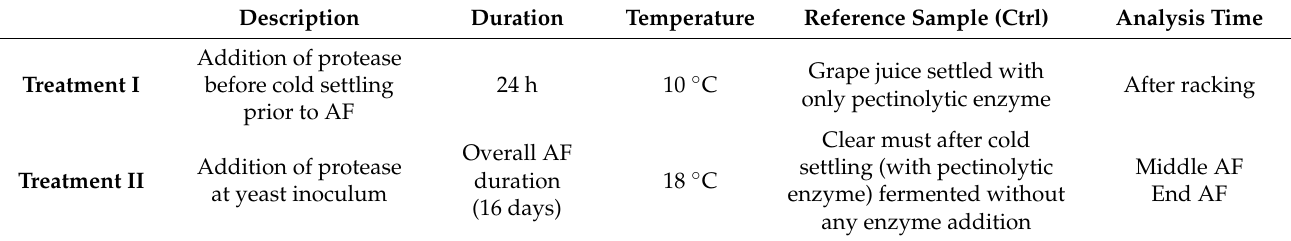
Table 1. Detailed frame of the applied